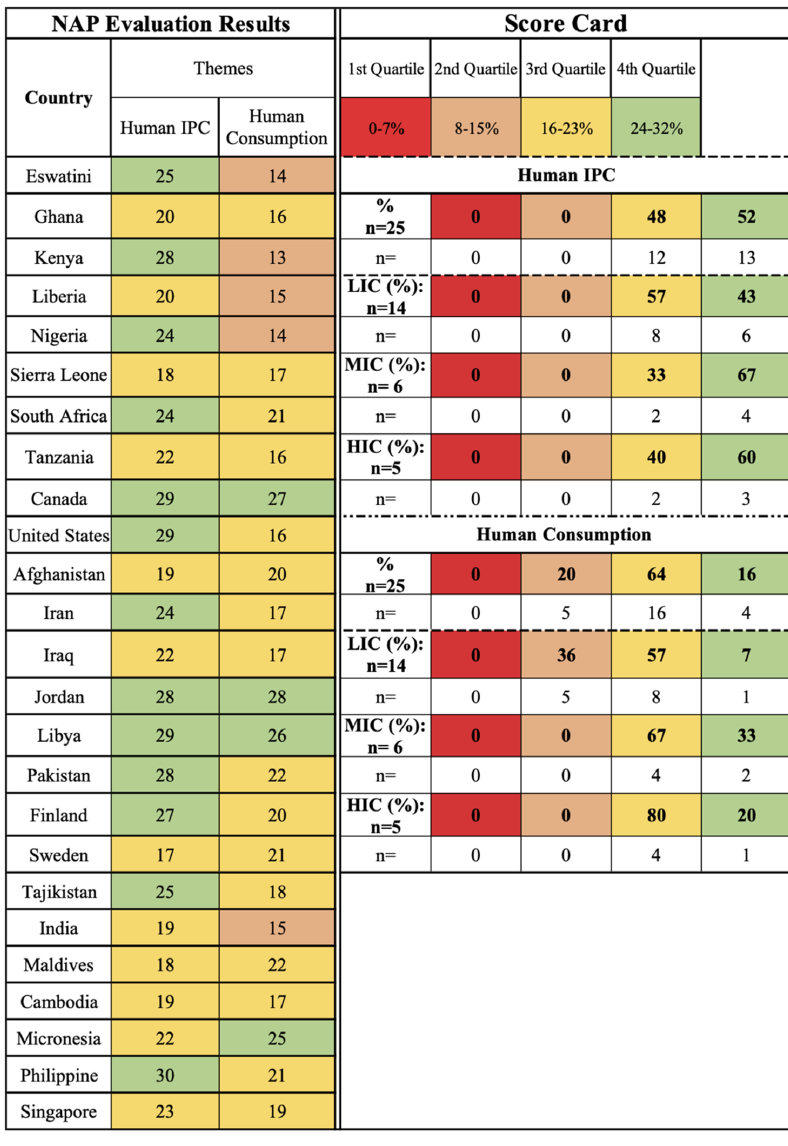
Figure 3. Human sector themes (human IPC and antimicrobial consumption) scorecard by country and income level.